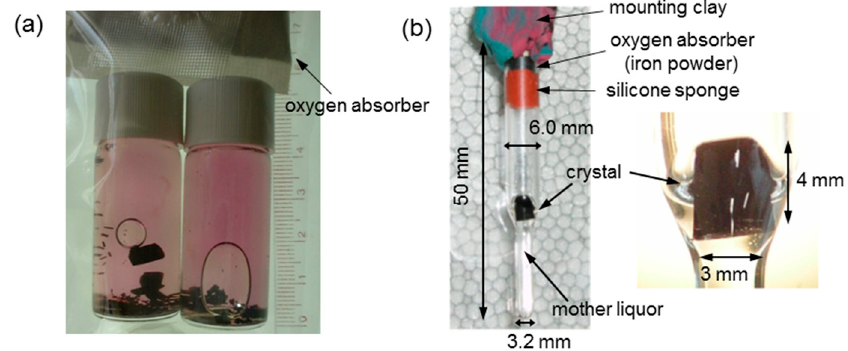
Figure 4. Large-volume, deuterated T-state deoxyHbA crystals for neutron crystallography (NC). ( a ) Batch samples at 55 days after the crystallization setup; ( b ) The sample for NC measurement. A deoxyHbA crystal of about 4 × 3 × 3 mm in size (~36 mm 3 ) was mounted in an anaerobic quartz capillary.